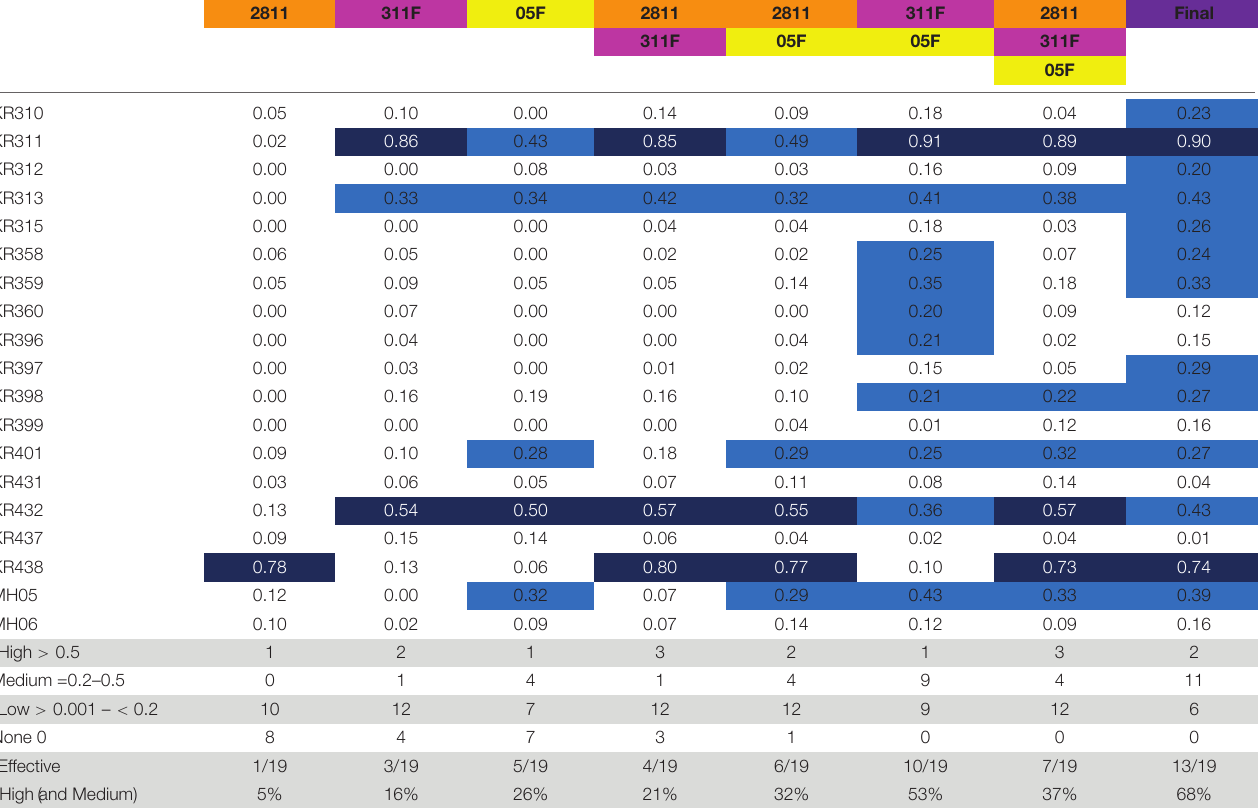
TABLE 2 | The virulence index scores of individual phage and various phage combinations across all the 19 ESBL-producing Klebsiella clinical